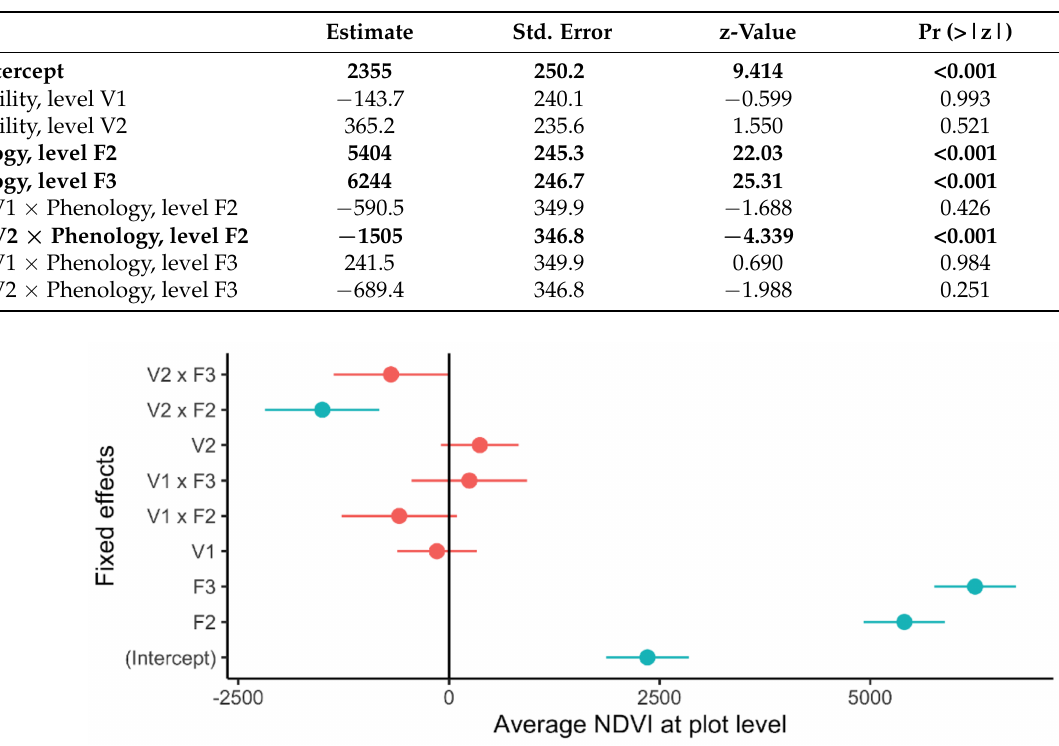
Table 5. Model 2, estimation of fixed effects for the “Nested, no Practice factor” NDVI optimal mixed-effects model. Contrasts are level V0 for the Vulnerability factor and F1 for the Phenology factor (F1: emergency phase, F2 stem elongation phase, F3 flowering phase). Significant explanatory variables at p < 0.001 level are shown in boldface. Adjusted p values reported.